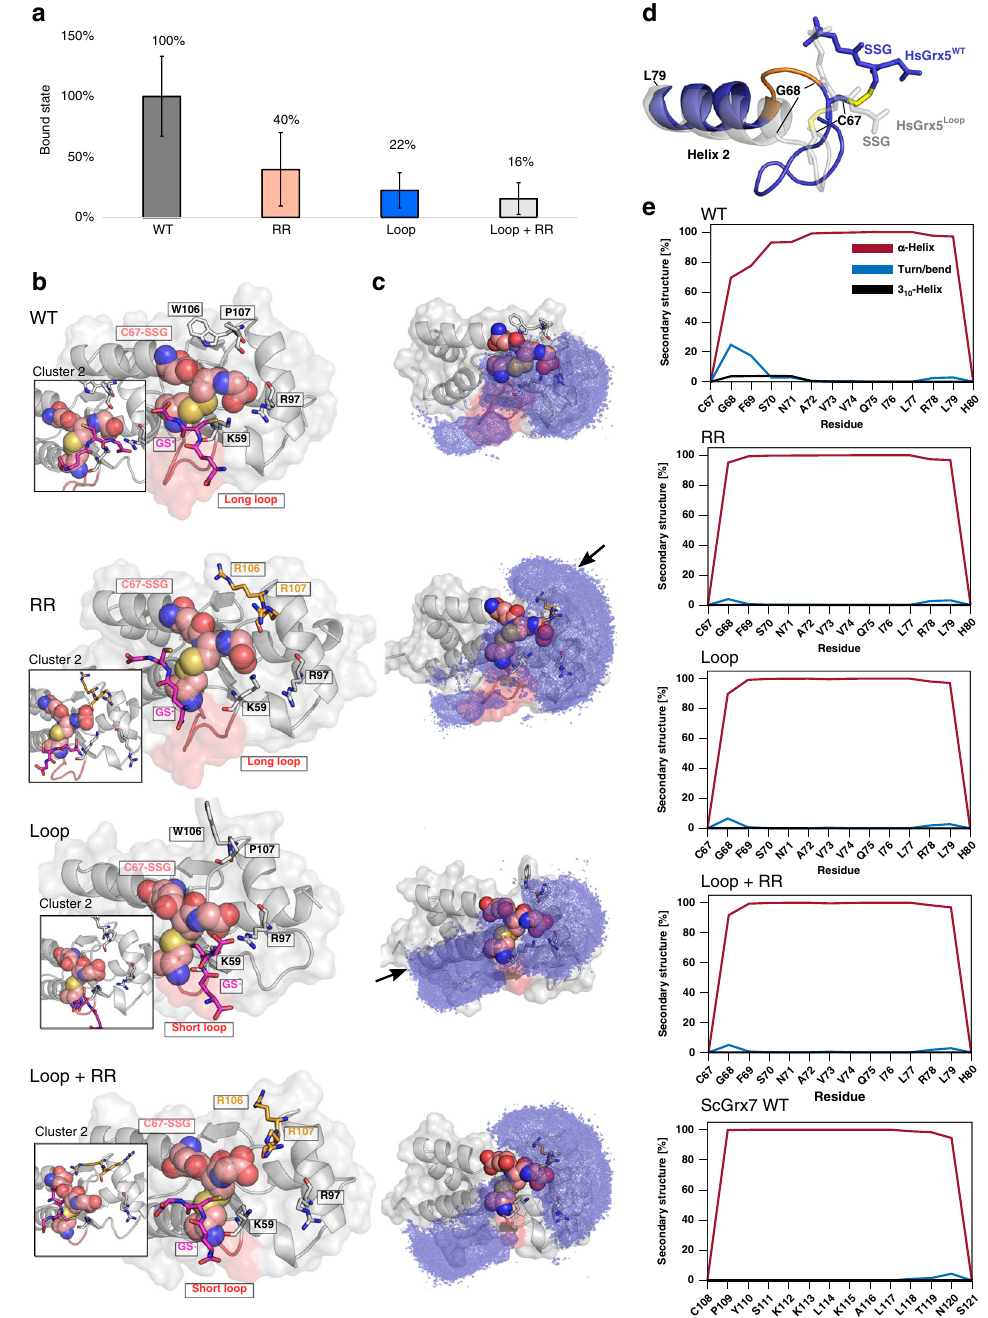
Fig. 9 GS − binding to and conformational changes of glutathionylated HsGrx5 variants. a Fraction of bound states with the value for wild-type HsGrx5 (WT) normalized to 100%. Error bars show the standard error of the mean over four replications for each system. Datasets were tested with a two-tailed t test assuming unequal variances; null-hypothesis of equal means could not be rejected with P < 0.05. For WT and HsGrx5 RR P = 0.17; for WT and HsGrx5 loop P = 0.10; for WT and HsGrx5 RR + loop P = 0.08. b For each of the systems of the WT and the variants HsGrx5 RR , HsGrx5 loop , and HsGrx5 RR + loop , bound states were clustered with respect to the structural deviation of the active site and the closest GS − from the solution. The structure representing the most populated cluster is shown in the middle, and important areas of the structure representing the second most populated cluster are shown in the boxes next to it. The covalently bound glutathione moiety at Cys67 is depicted in salmon, the freely diffusing GS − in pink. Residues marked in orange show the mutated residues in the variants; the active site loop is colored red. Residue are numbered always according to the WT sequence. c The occupation density of the diffusing GS − is shown as a blue grid on the structure of each HsGrx5 variant. Bound states were combined across replications for this analysis, and the threshold of the density grids is the same for all variants. Arrows show the additional patterns emerging for the RR and loop variants compared to the WT, respectively. d Partial unfolding of helix 2 (residues marked orange) was observed in one of the replications of HsGrx5 WT (blue), HsGrx5 loop is shown for comparison of the helical conformation (gray). e Residue-wise fraction of secondary structure content averaged over the four MD replications of the HsGrx5 variants and the ScGrx7 WT for helix 2. Only relevant secondary structure types are shown: α -helix in red, turn or bend in blue, and 3 10 -helix in black. Adjacent residues Cys67/Cys108 and His80/Ser121 have a coil